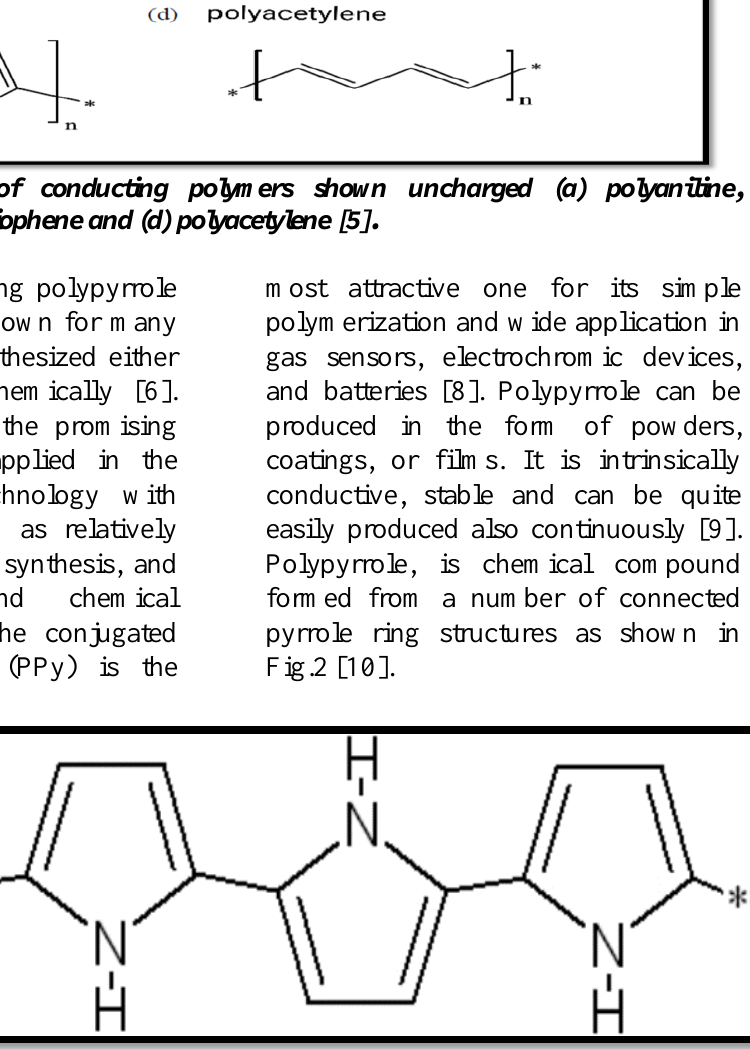
Fig.2: The structure of polypyrrole (PPY) in the neutral state